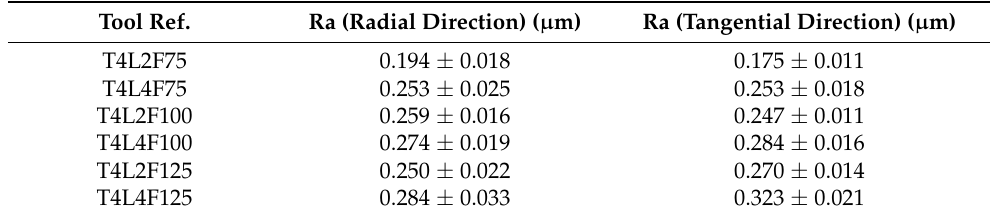
Table 11. Average surface roughness values, measured in the radial and tangential directions for the tests conducted with T4. Tool